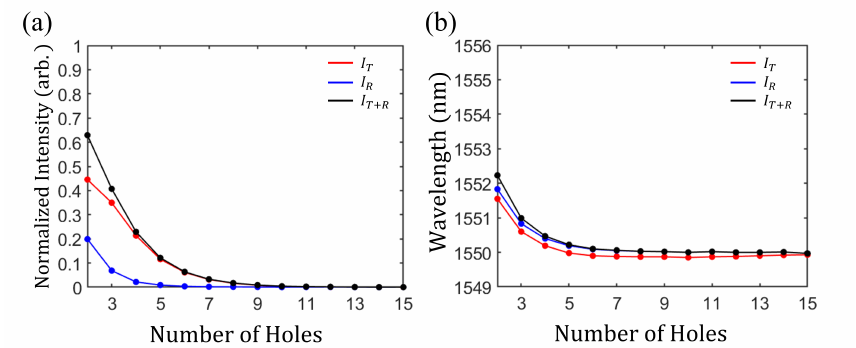
Figure 5. ( a ) Normalized intensity of the peak in transmission spectra ( I T ) and the dip in reflection spectra ( I R ) for various number of holes of PC at PMC-like boundary. I T and I R are depicted as red and blue circles respectively. The black circles show the dip in total intensity spectra ( I T + R ), dip in sum of intensities of transmission and reflection spectra. When number of holes of PC increases, all I T , I R and I T + R are decreased. ( b ) Wavelength of I T and I R vs. number of holes. Red and blue circles represent the wavelengths of I T and I R . Wavelength of I T + R are depicted as black circles. When number of holes are increased, all wavelengths of I T , I R and I T + R are blue shifted to approximately 1550